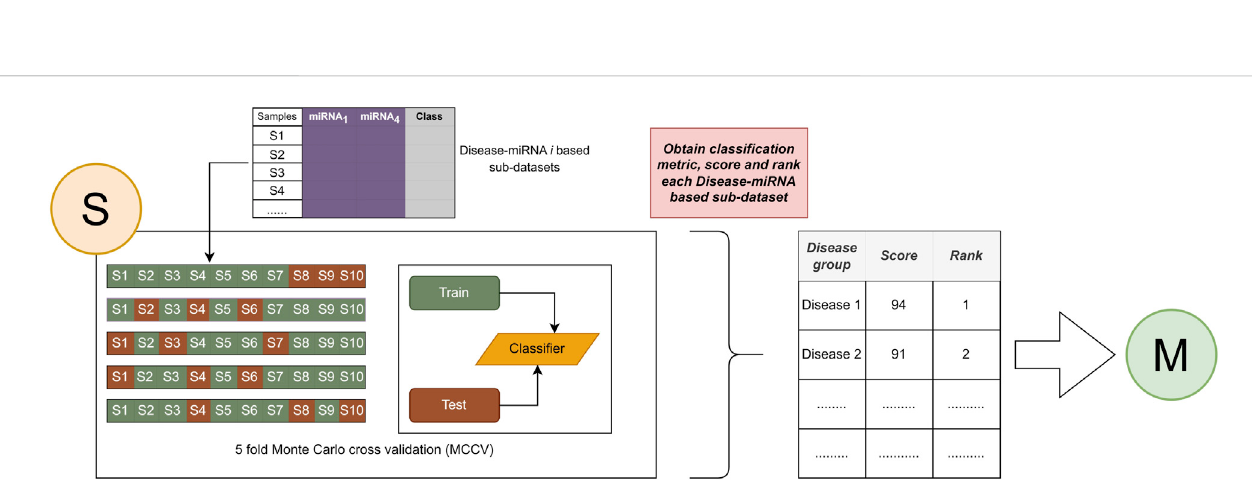
FIGURE 4 Assign an importance score to the associated disease and apply the ranking